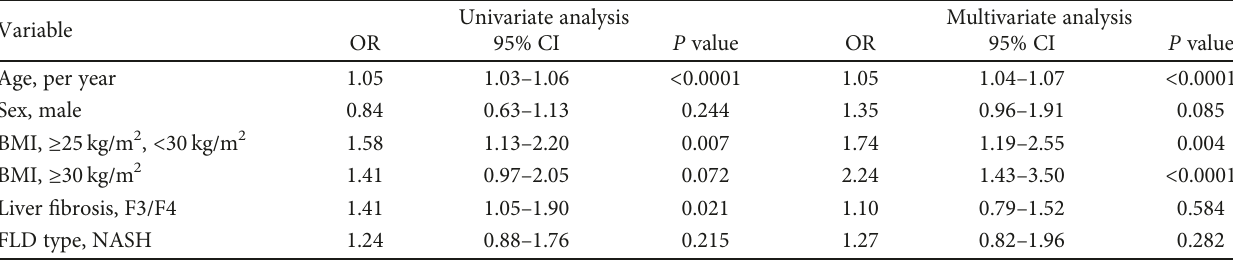
Table 2: Associations of ASH and NASH with HT.